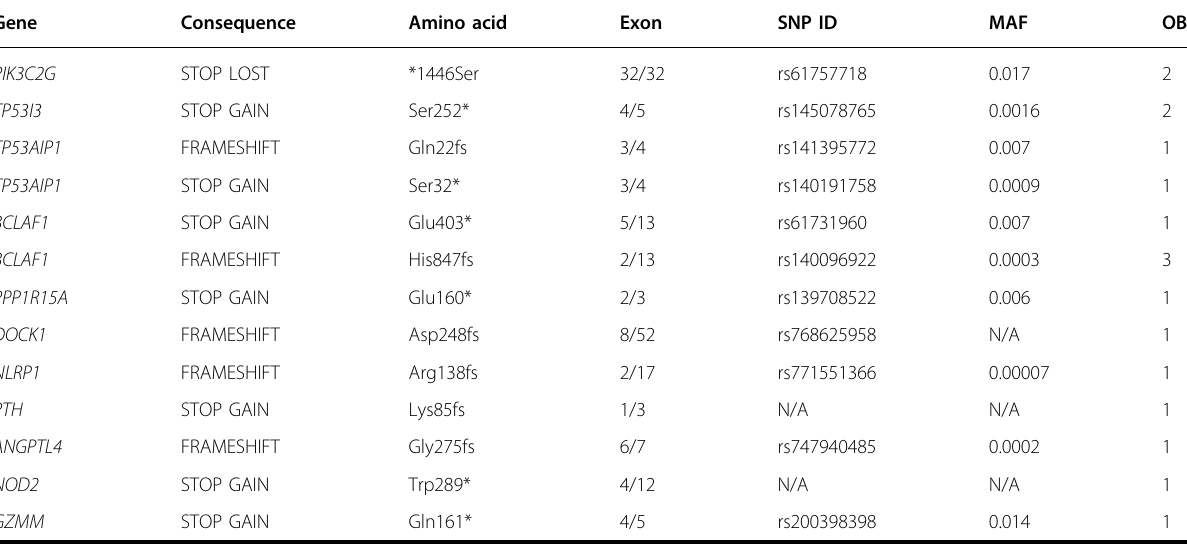
Table 1 Candidate risk mutations in apoptosis genes.